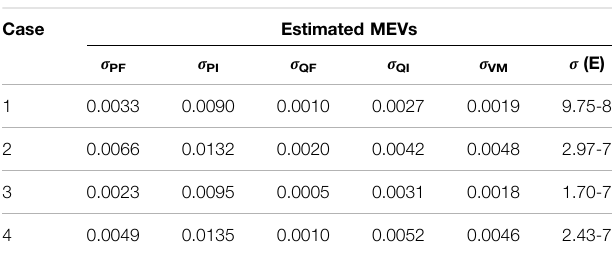
TABLE 5 | Estimated MEVs of the IEEE 118-bus system ( N LME =